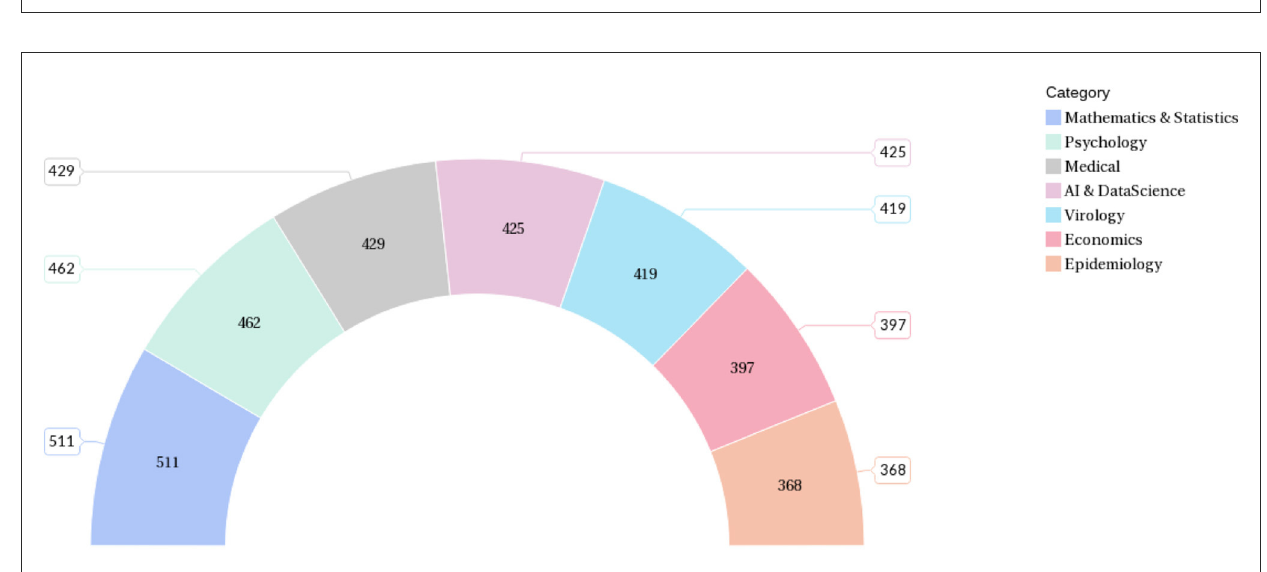
FIGURE7 Number of data samples (articles) assigned to the class categories.